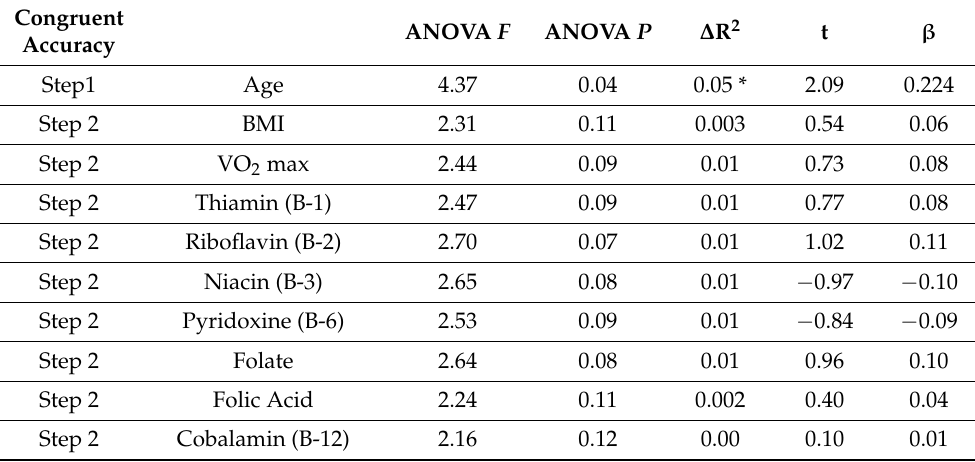
Table 3. Congruent Accuracy